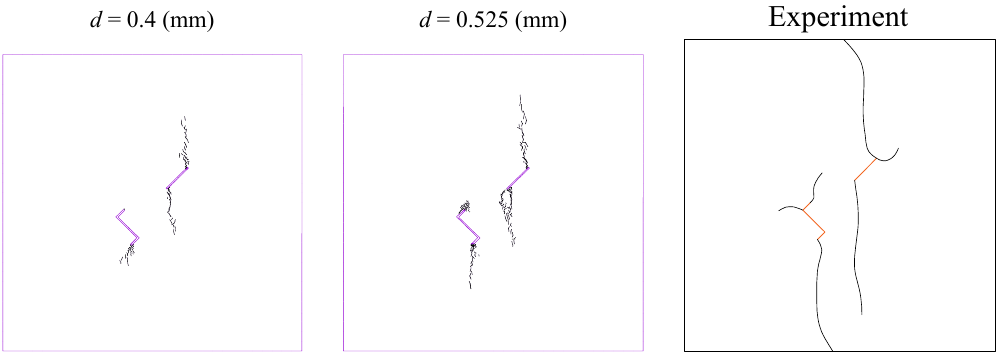
Figure 16. 3D-printed materials with two intermittent fissures ( α = − 90 ◦ ): the crack opening plots (deformation scale 1:1) compared to the experimental results provided in